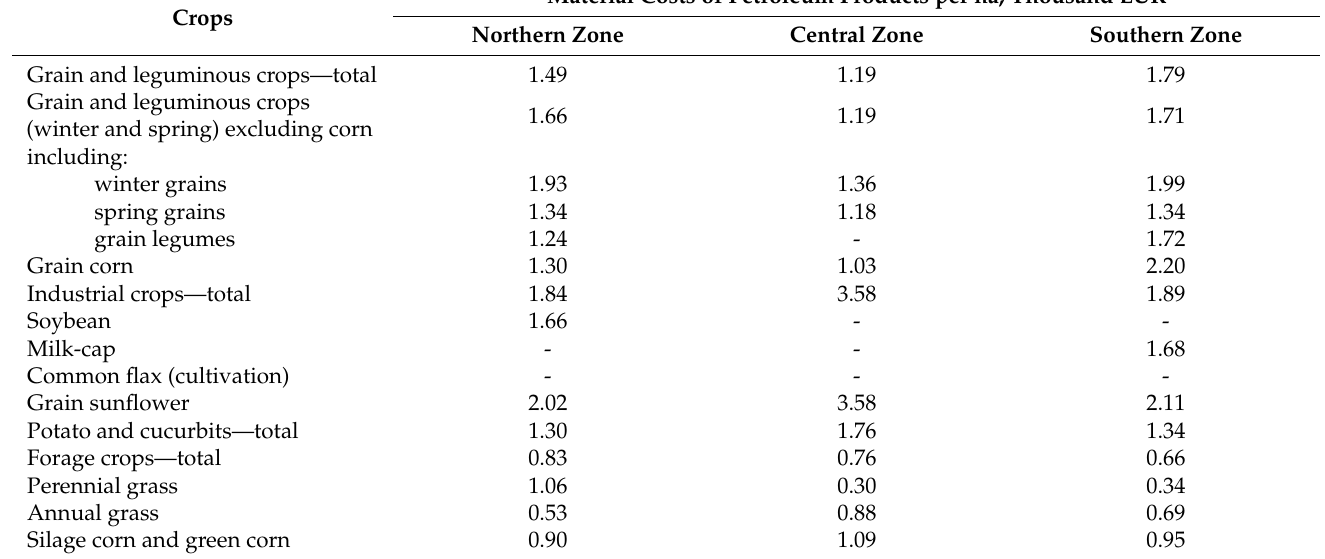
Table 4. Material costs of petroleum products for cultivation of agricultural crops in zones.